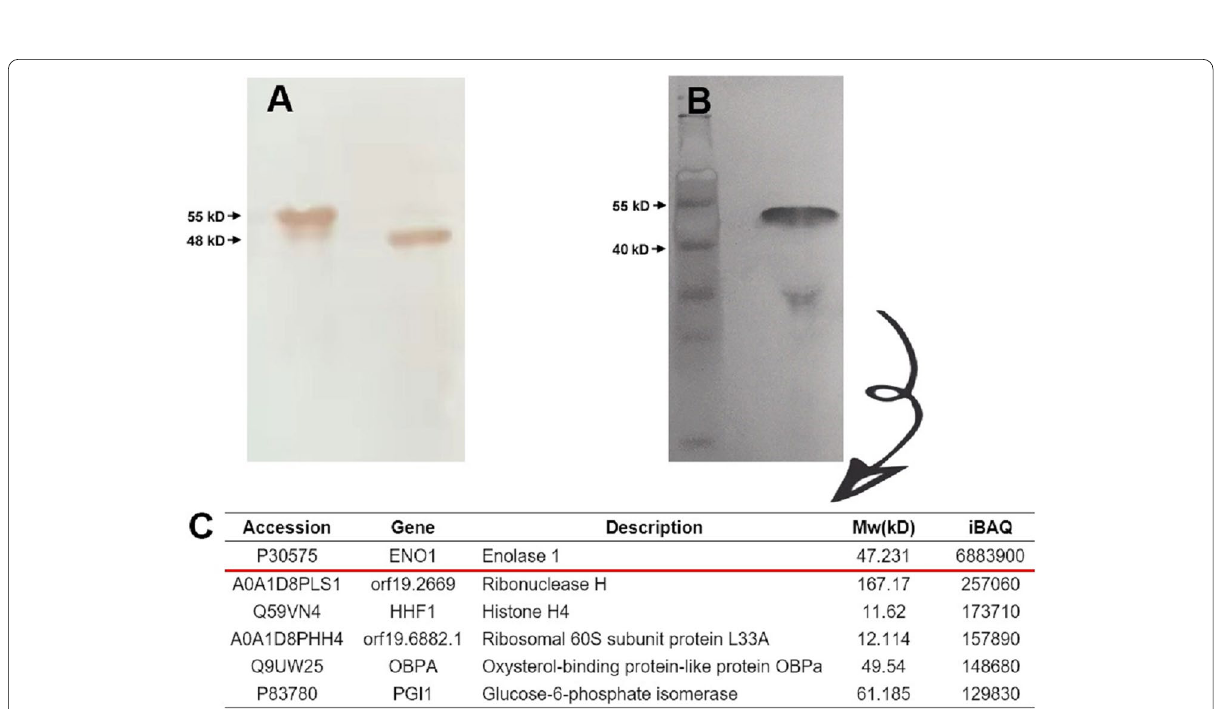
Fig. 2 Validation of the specificity of 10H8 mAb. A Western blot analysis showed the 10H8 mAb specifically reacted with the 55 kD recombinant CaEno and recognized a 48-kD protein in the total Candida albicans lysates. B SDS-PAGE (sliver stained) analysis of the 10H8 immunocapture elute. C LC MS/MS analysis of the 10H8 immunocapture